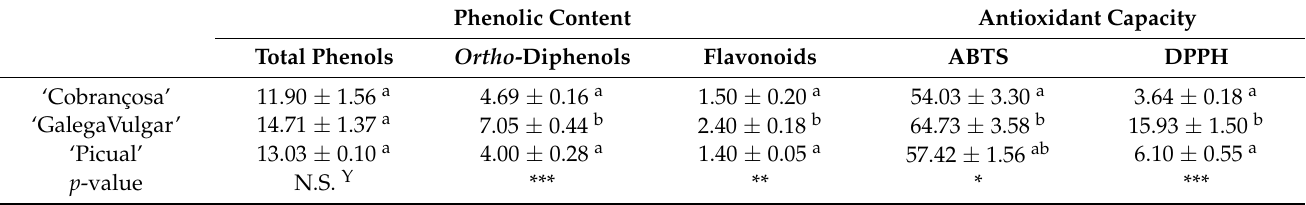
Table 1. Total phenol (mg GA (Gallic Acid) g − 1 DW (Dry Weight)), ortho -diphenol (mg GA g − 1 DW), and flavonoid (mg CAT g − 1 DW) content and antioxidant capacity ( µ mol Trolox g − 1 DW) of olive seeds from different cultivars. Phenolic Content Antioxidant Capacity Total Phenols Ortho -Diphenols Flavonoids ABTS